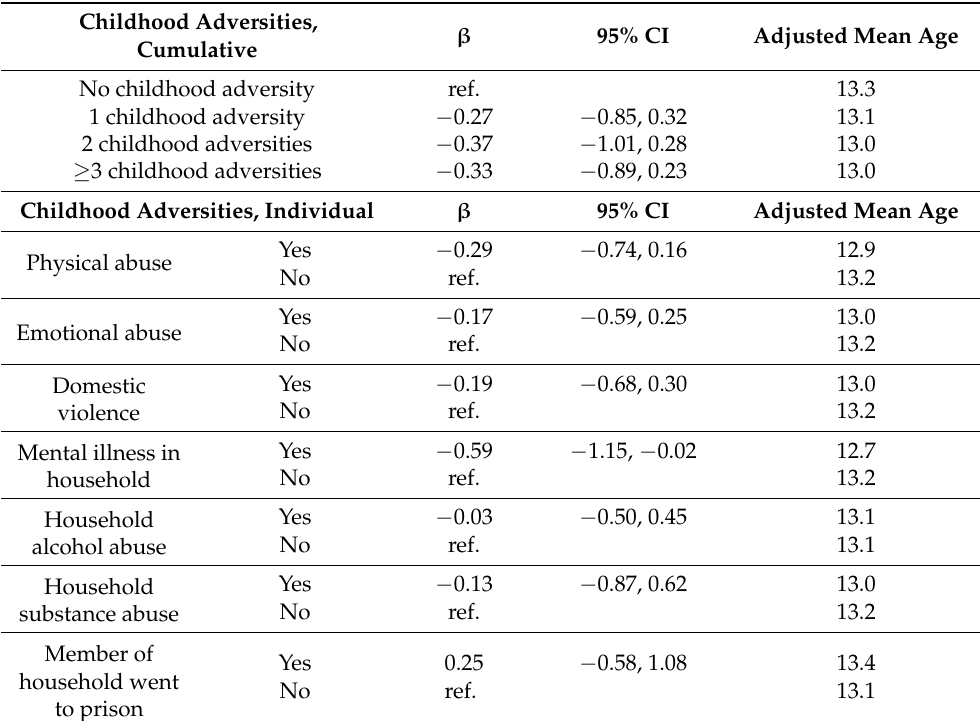
Table 2. Multivariable associations between indicators of childhood adversities and age at menar- che (years).